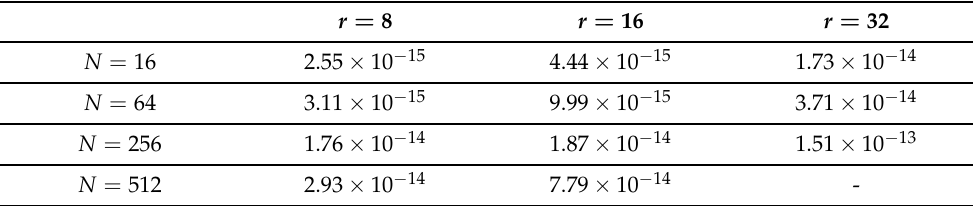
Table 4. The maximum errors of eigenvalues computed by Algorithm 1.